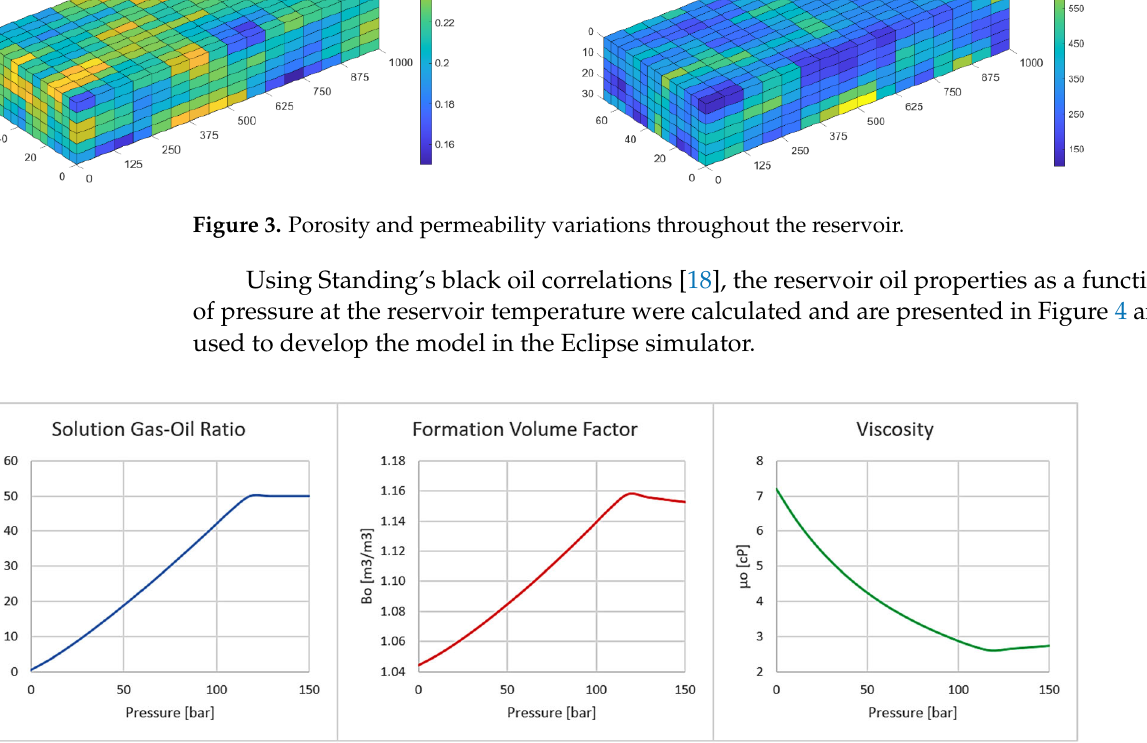
Figure 4. The physical oil properties as a function of the pressure at the reservoir temperature.